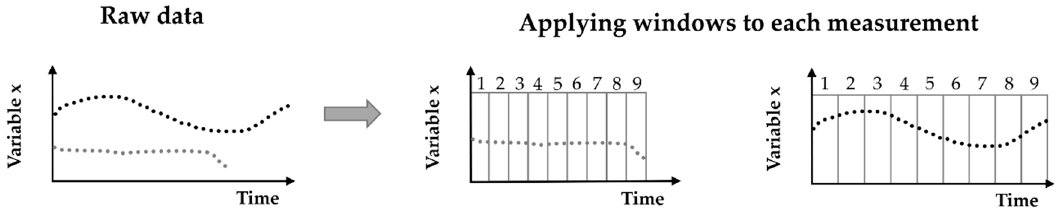
Figure 2. Visualization of pre-processing the data by subdividing each measurement into 9 windows. The black and grey dotted lines represent two fictional measurements for a certain variable x. Although the sampling frequency is the same for both measurements, the number of data points (i.e., length of the measurement) is not fixed. Accordingly, the number of data points inside the windows varies as well between the